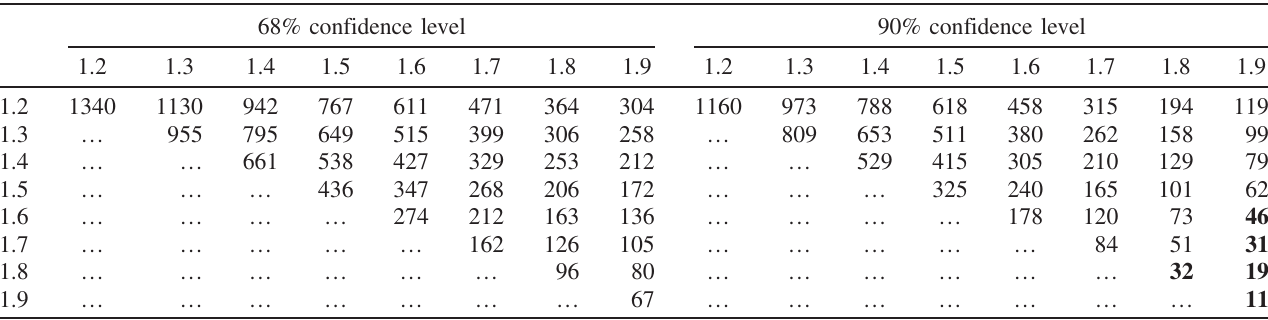
TABLE V. Frequency f (in Hz) at which dynamical scalarization occurs for various unequal-mass binaries with the EOS MPA1 . DS Results are given for theories that saturate the constraints given in Table II at 68% and 90% C.L.s. Binary systems are specified by their component NS masses, given in units of M ⊙ . We highlight systems that scalarize at frequencies below 50 Hz with